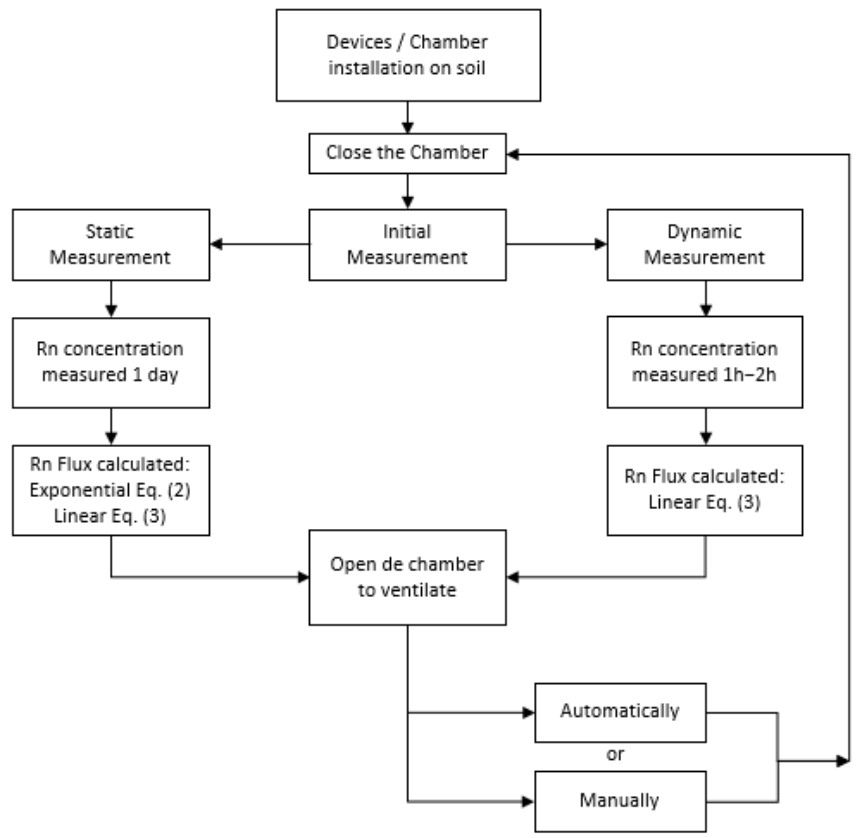
Figure 7. Flowchart of the methodology applied to radon flux measurements in field.